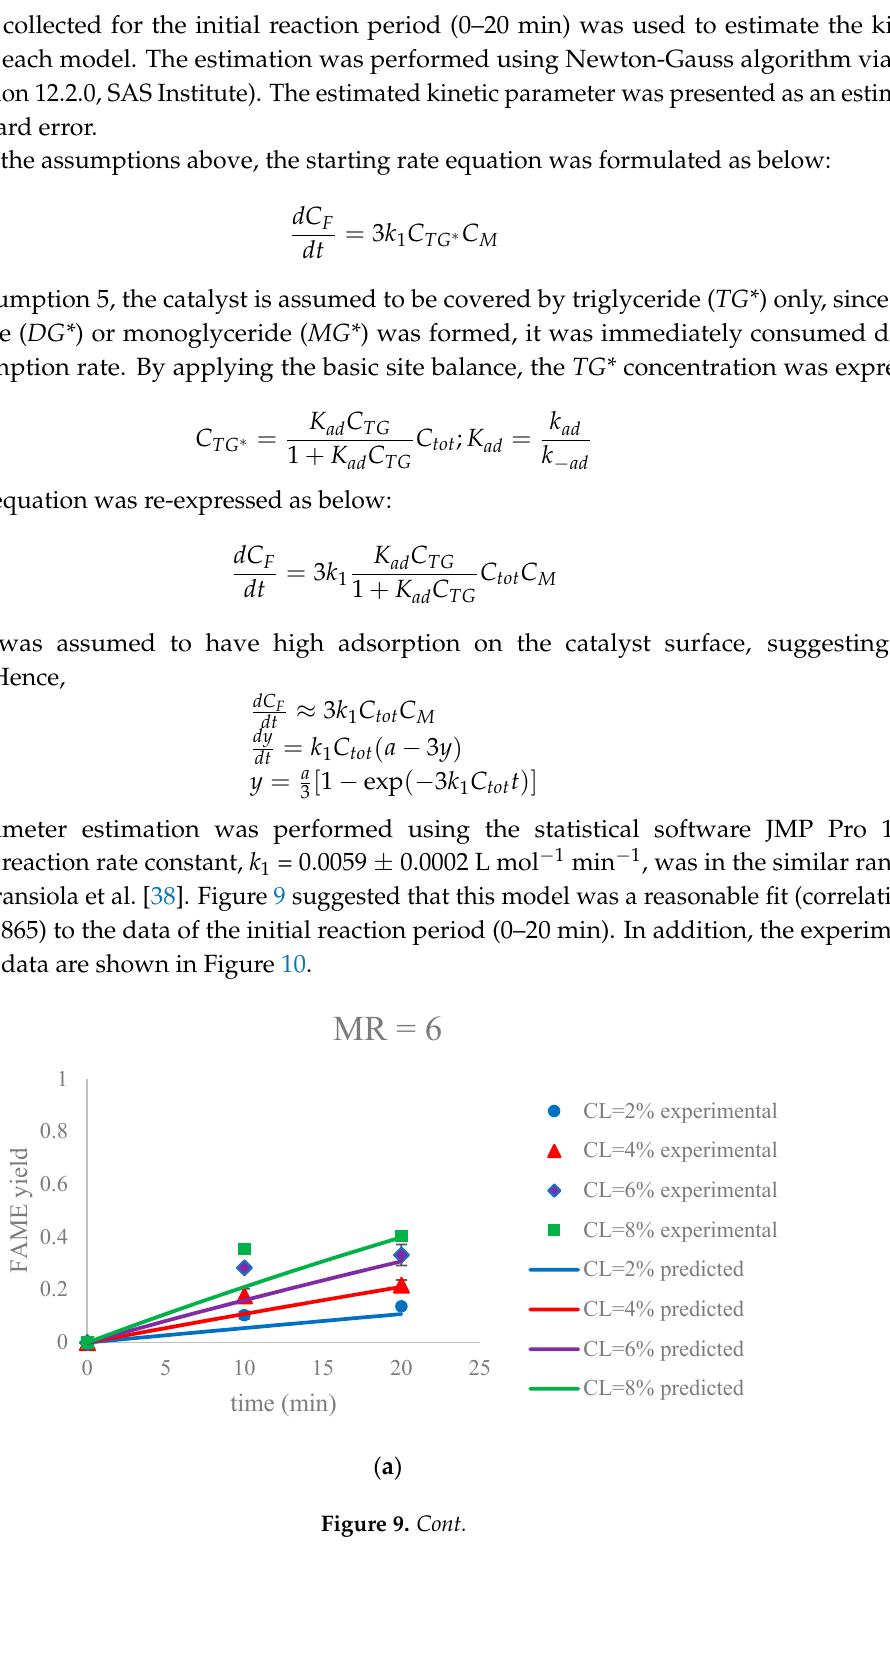
( b ) ( c ) Figure 9. The FAME yield with the progress of the soybean oil transesterification catalyzed by Na- COS in the initial period (0–20 min) grouped by MR ( a ) MR = 6; ( b ) MR = 12; ( c ) MR = 18. Error bars represent standard error.